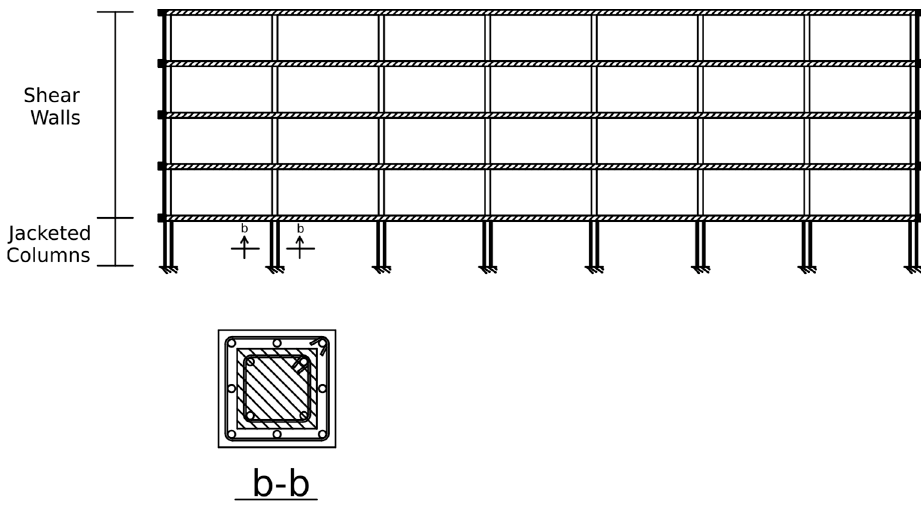
Figure 2. Reinforced concrete columns jacketing with shear walls strengthening (Case 2).